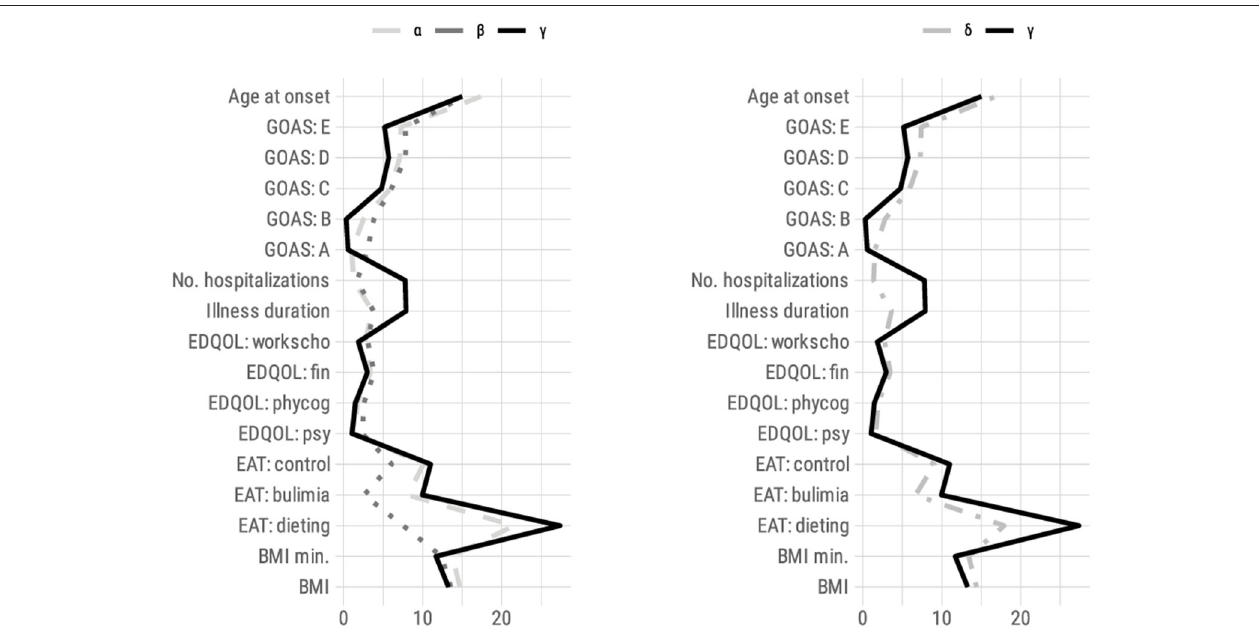
FIGURE 2 | Profile of responses (mean) for all variables used in hierarchical clustering for each cluster solution (left: three clusters; right: two clusters). BMI, Body Mass Index; EAT, Eating Attitudes Test; EDQOL, Eating Disorder Quality of Life; psy, psychological; phy cog, physical/cognitive; end: financial; work scho, professional/academic; No: number; GOAS, Global Outcome Assessment Scale by Morgan-Russell.